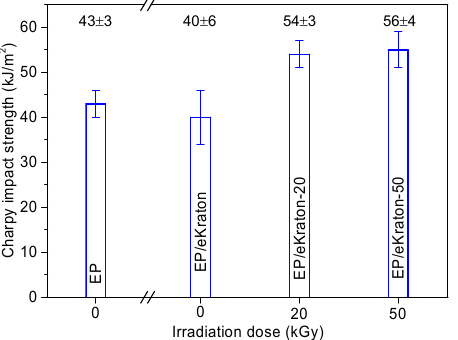
Figure 8. The Charpy impact strengths of EP/eKraton blends modified with different irradiation doses compared with neat epoxy thermoset. Table 3. Critical strain energy release rate (G IC ), critical stress intensity factor (K IC ), and modulus of elasticity (E) of the neat epoxy (EP) thermoset compared with EP/eKraton blends prepared with dif ‐ ferent irradiation doses (mean values and standard deviation).